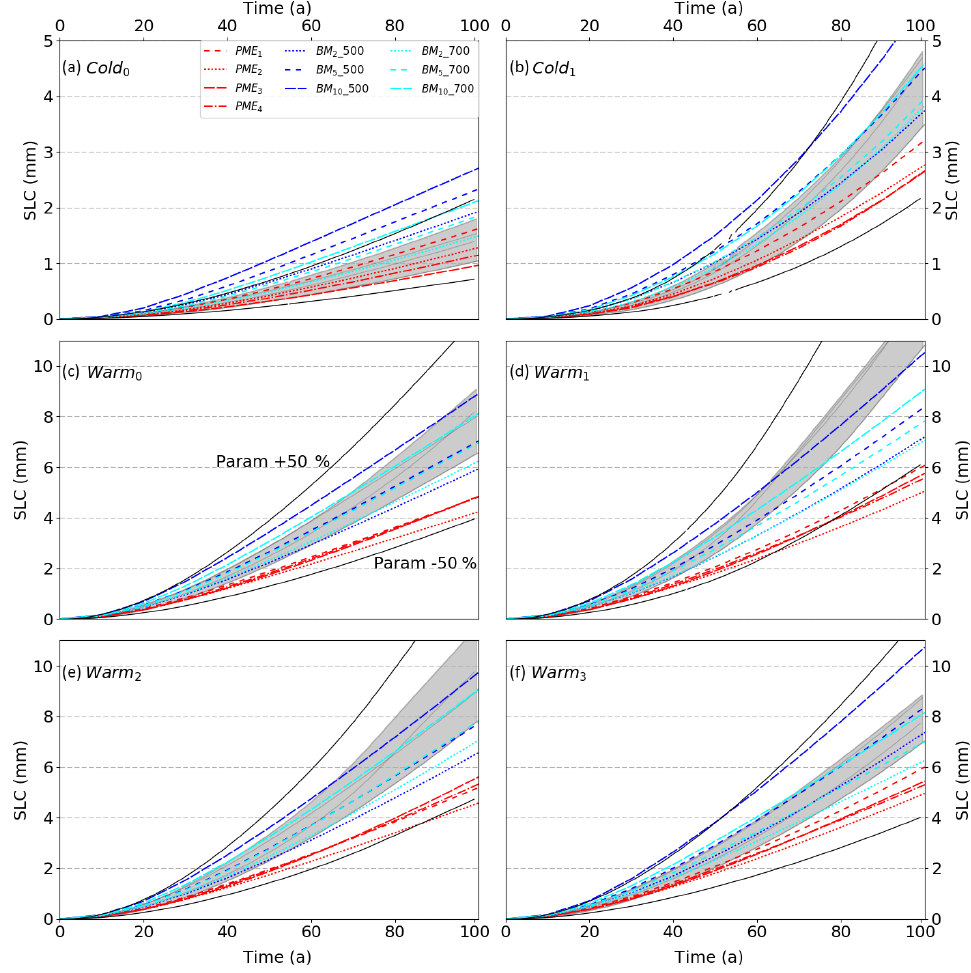
Figure 8. Similar to Fig. 7 but for more complex parameterisations (Sect.